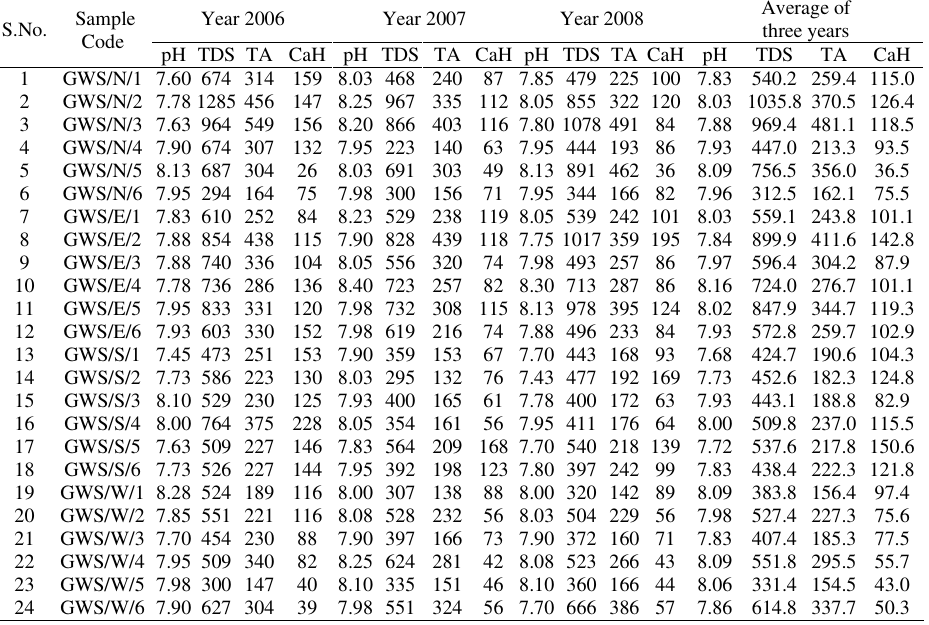
Average of three years